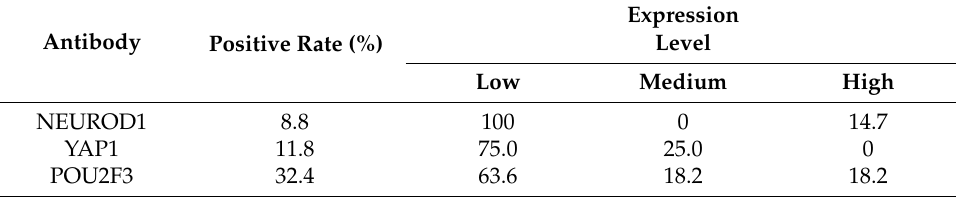
Table 3. Co-expression of NEUROD1, YAP1, and POU2F3 in the ASCL1-positive SCLC group